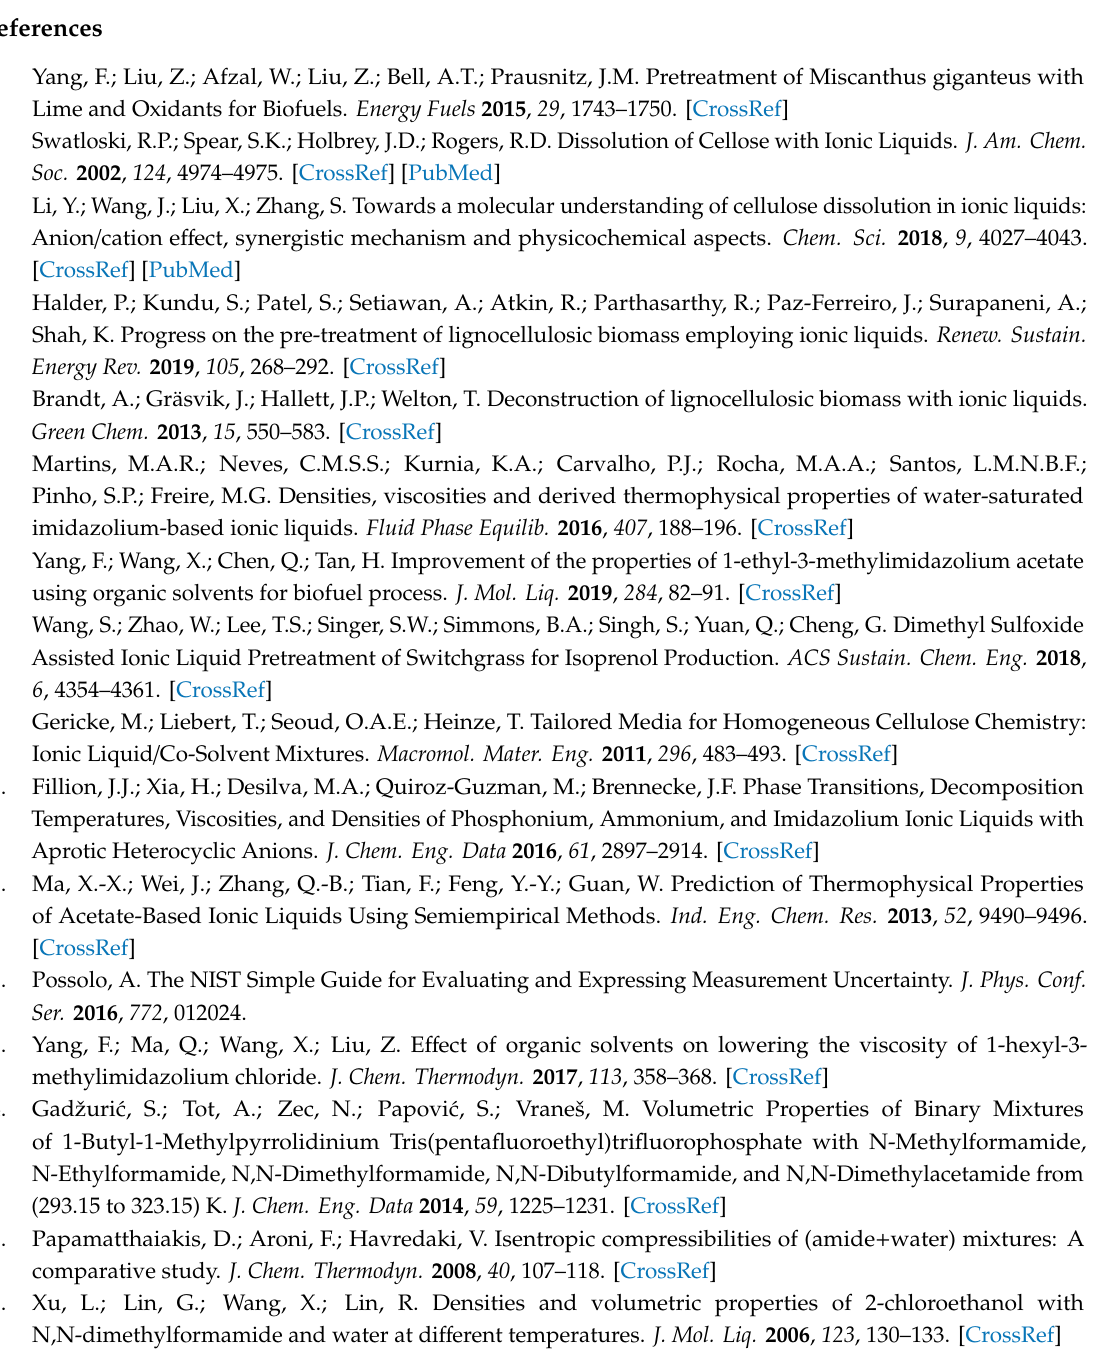
solvent of DMA, Figure S20: infrared spectra of pure IL with / without solvent of DMF, Figure S21: infrared spectra of pure IL with / without solvent of DMSO, Table S1: parameters fitted by the experimental data in this work for Equation